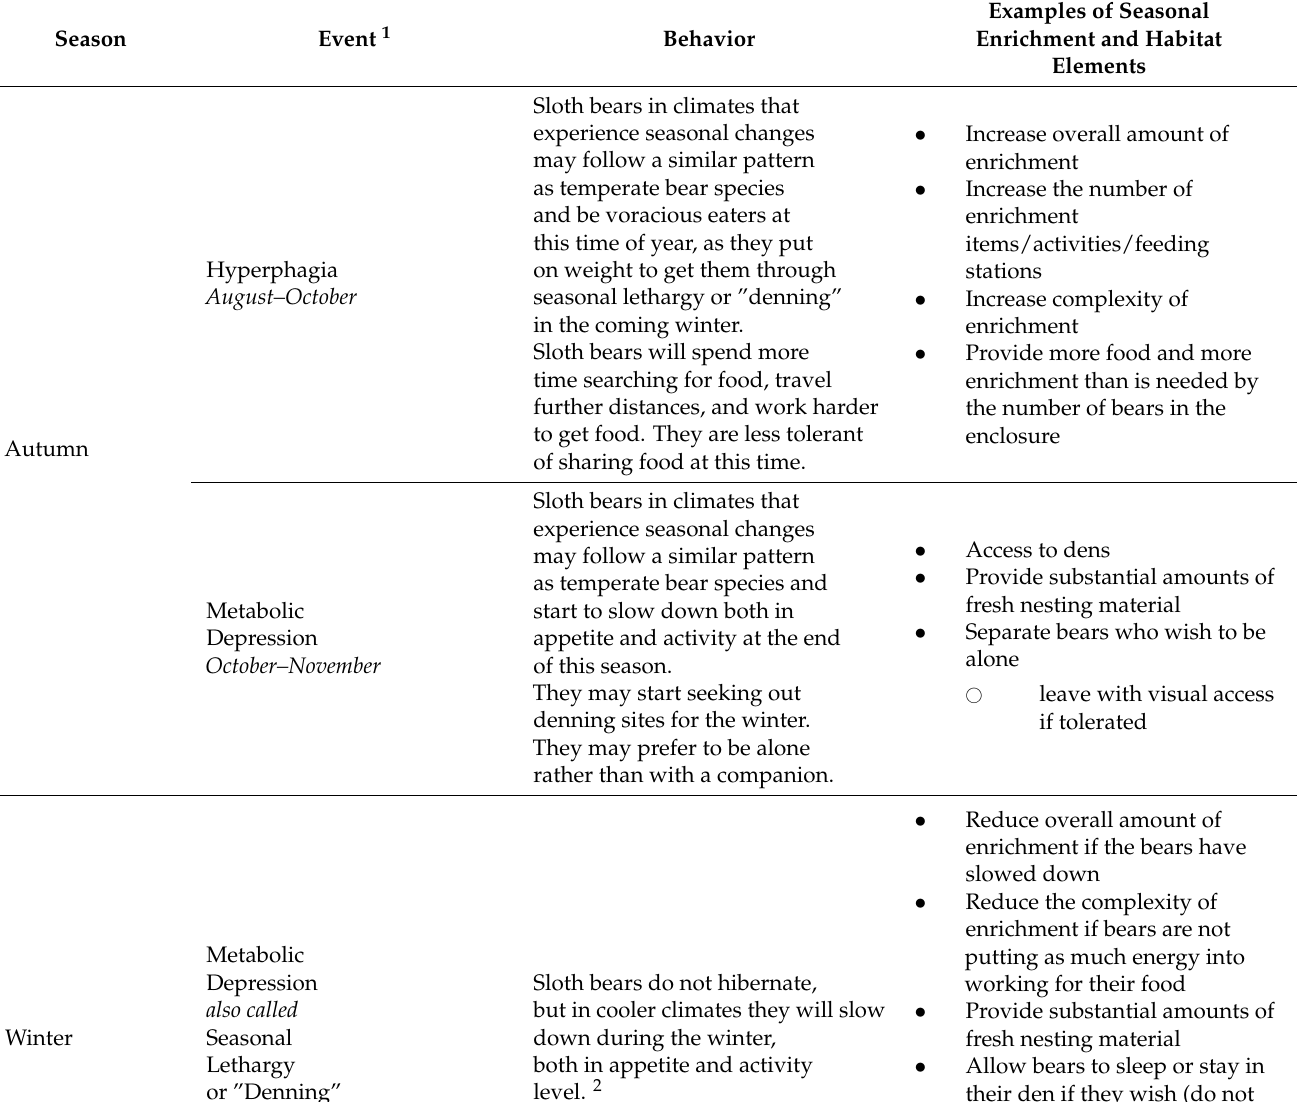
Table 3. Examples of behavior-based seasonal sloth bear